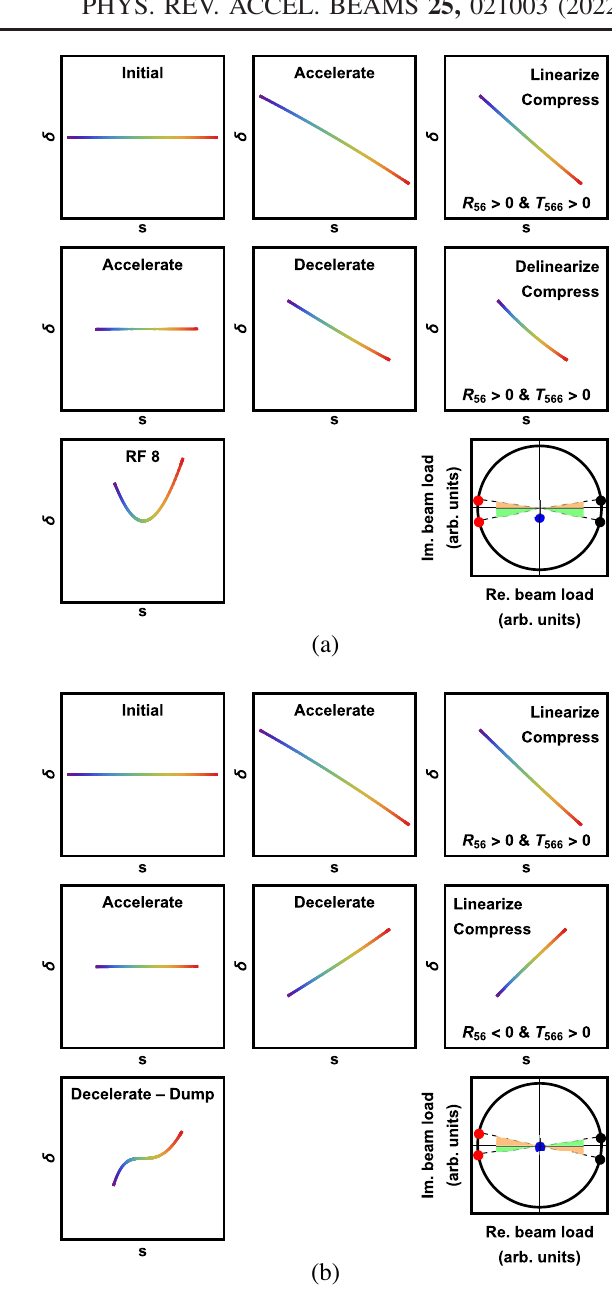
FIG. 8. Energy spread minimizing matches with nonisochro- nous intermediate arcs. rf beam load plot shows rf phase choices during acceleration (black), deceleration (red), and resulting beam load (blue). (a) Common transport, (b) separate transport. Different angle highlights in the rf load plots correspond to different magnitudes off-crest or